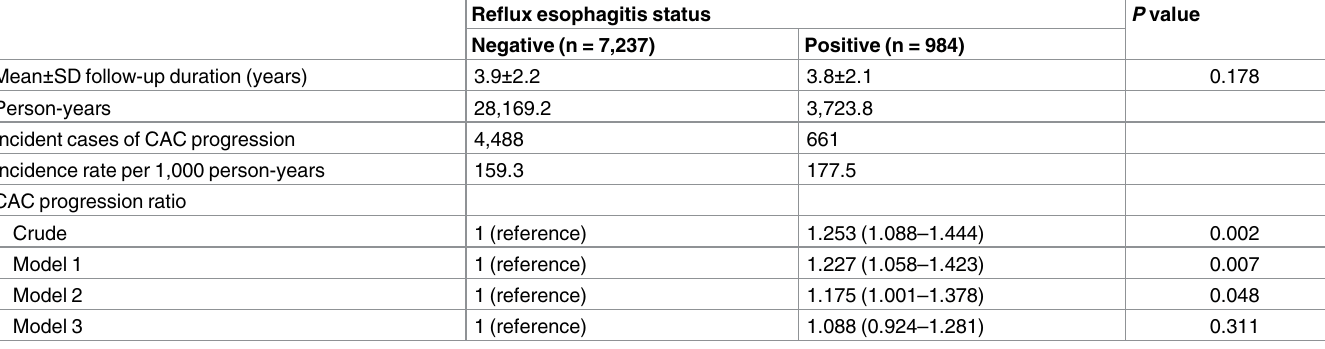
Table 3. Ratio of the coronary artery calcium (CAC) score progression according to the reflux esophagitis status at